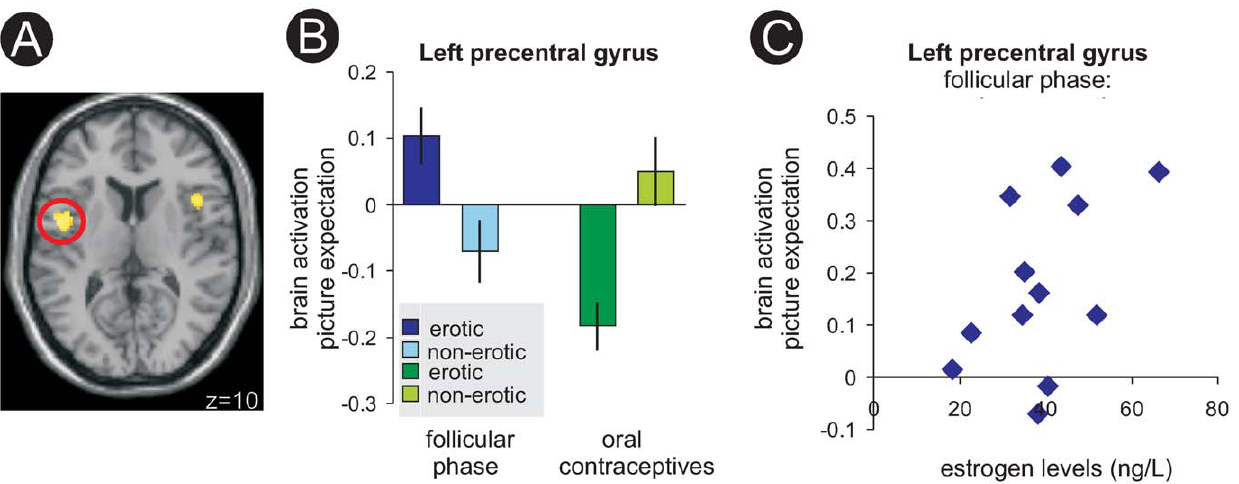
Figure 2. Differential brain activation in the precentral gyrus upon expectation of picture stimuli. A – differential brain activation in bilateral precentral gyrus during expectation of picture stimuli (nC-F [erotic minus non-erotic] . C [erotic minus non-erotic]) thresholded at p=0.001 uncorrected, minimum 10 voxels per cluster. B – parameter estimates of modelled effects of brain activation in the left precentral gyrus in the follicular phase (nC-F group) and under oral contraceptives (C group) upon picture expectation. C – Illustration of the relationship between differential brain activation upon picture expectation (erotic minus non-erotic) in the precentral gyrus and estrogen levels in the nC-F group. Color coded bars represent T-levels.